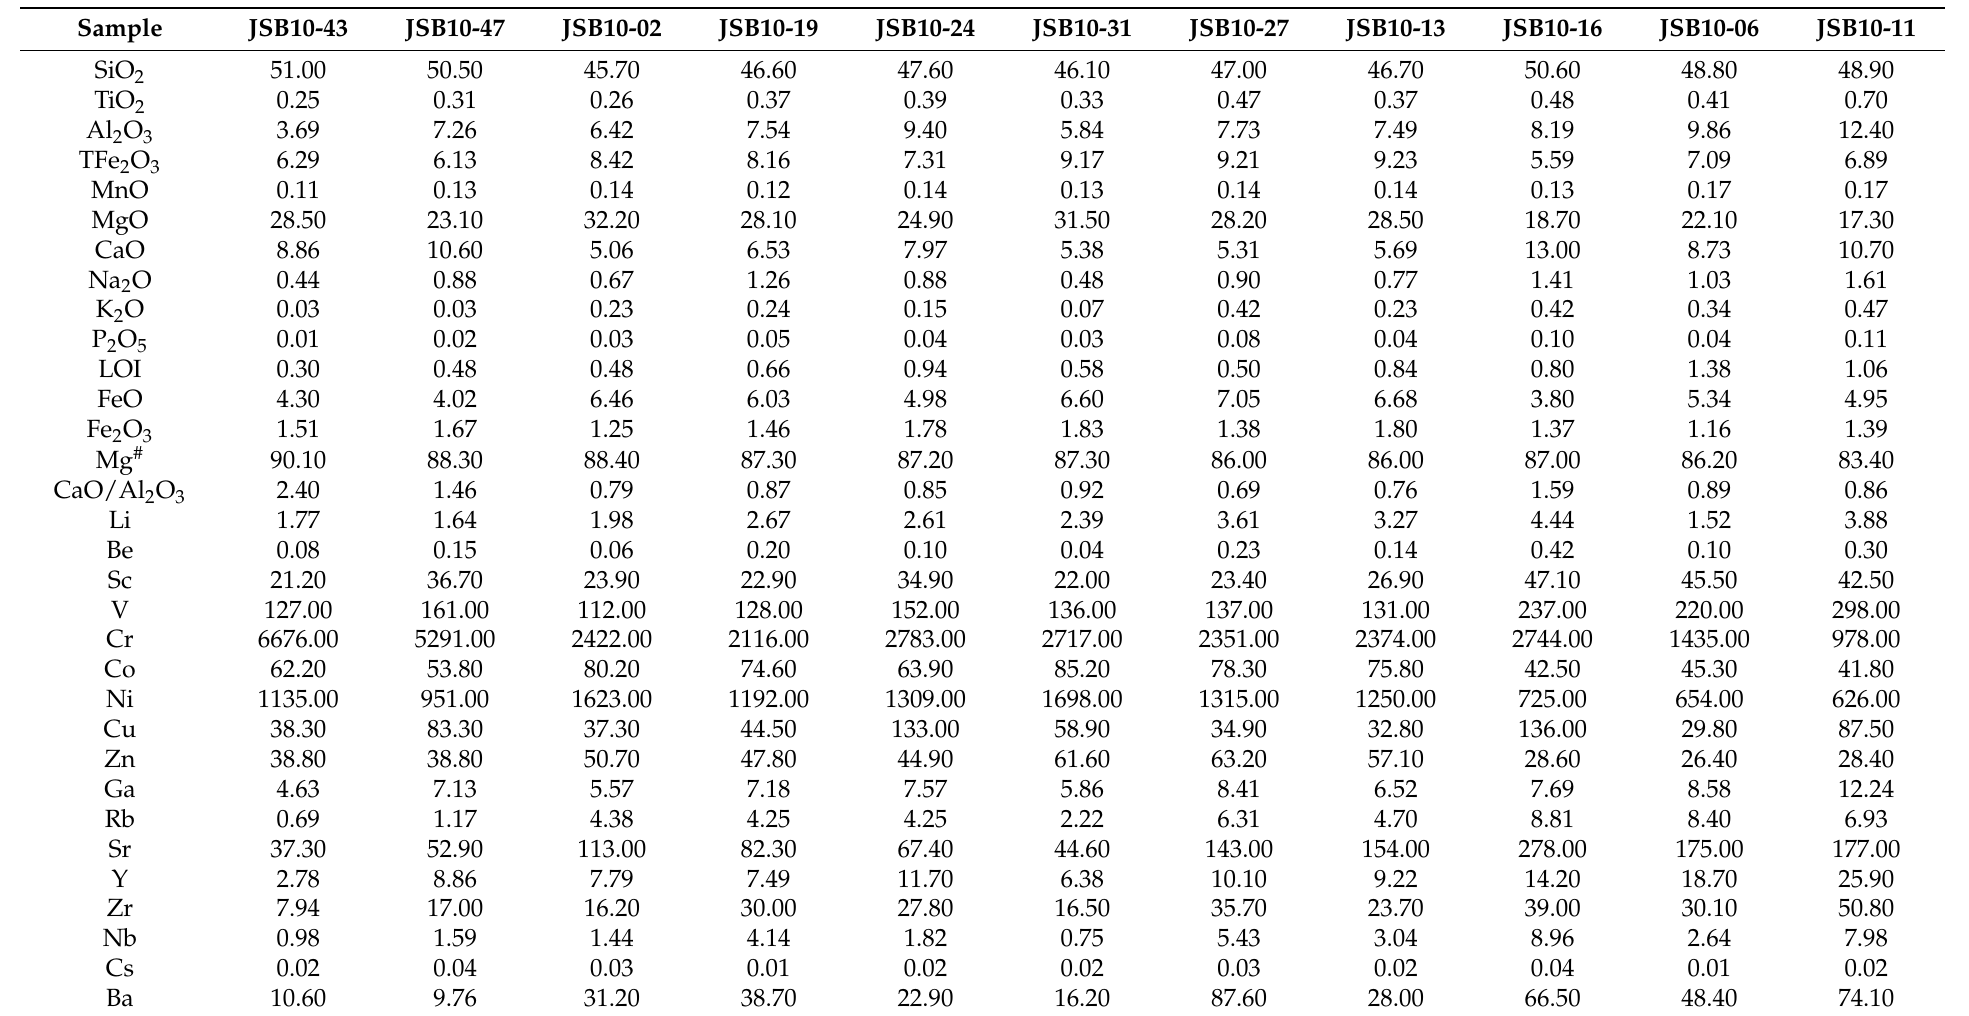
Table 1. Major (wt%) and trace element (ppm) compositions of the websterite